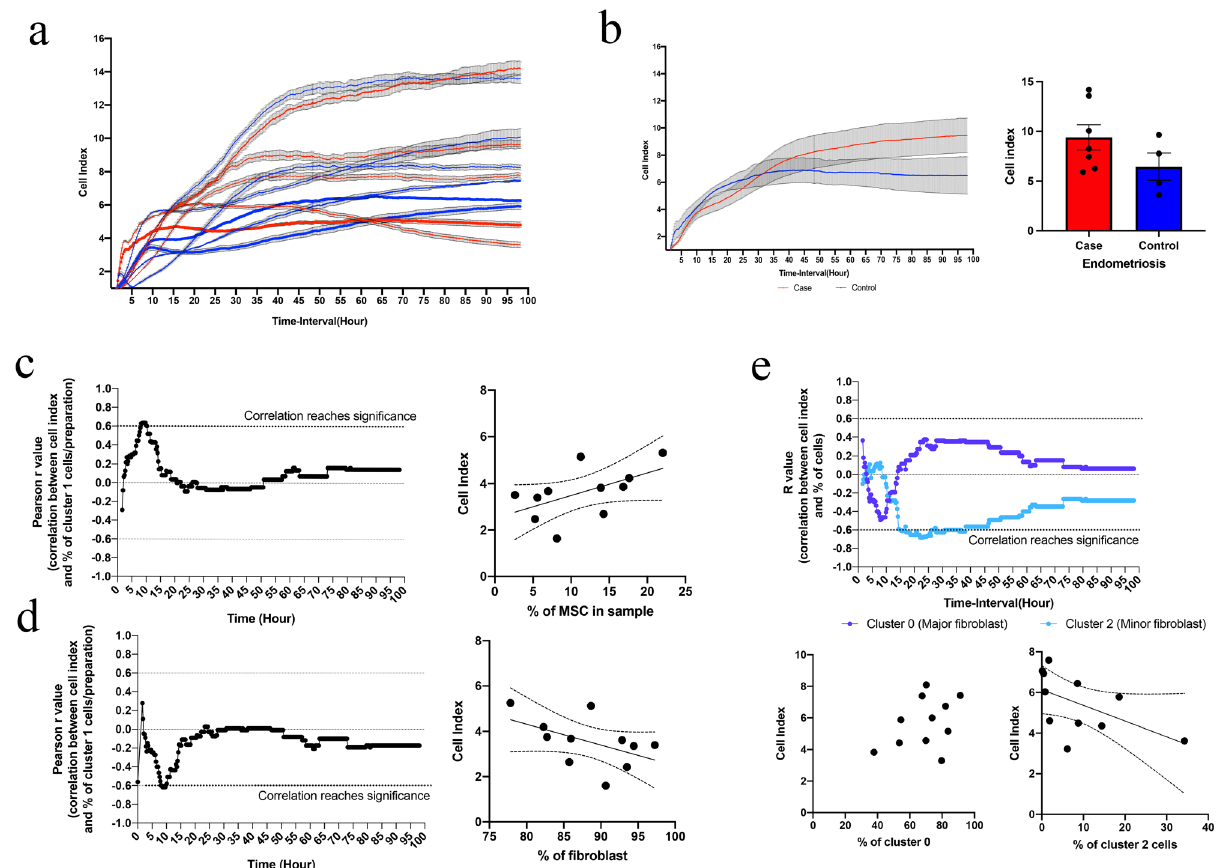
Fig. 5 Relationship between cell types and cell clusters and in vitro behaviour. We assessed cell growth rates over a 100 h period with the xCELLigence assay and compared the cell index to the percentage of cell types, or cell clusters identi fi ed in each cell preparation. a A comparison of the cell index for each individual preparation showed large variations in growth rates. b Categorisation of cell preparations based on endometriosis status showed varying rates of increase for both cases and controls across the 100-h growth assay. At the 100 h endpoint, the number of cells was higher for endometriosis cases ( n = 7) compared to controls ( n = 4), although not statistically signi fi cant when compared with an unpaired t test ( p = 0.1737). We subsequently compared the percentage of cell types in each preparation with the cell index using the Pearson correlation coef fi cient across all time points. This identi fi ed an increasingly positive correlation with cell index that reached signi fi cance (dotted line) with c MSC between 8.25 and 9.75 h after cell seeding ( P = 0.0402), peaking at 9.25 (inset correlation graph). Conversely, for fi broblasts ( d ), a signi fi cant negative correlation ( p = 0.0478) with cell index was observed at the same time point (inset correlation graph). e Lastly, a comparison with the fi broblast cell clusters revealed the association with cell growth was strongest between 17 and 26 h after initial seeding, with the slower growth rate of cluster 2 reaching signi fi cance (inset correlation graph) during this time period ( p = 0.0251). Error bars represent the standard error of the mean